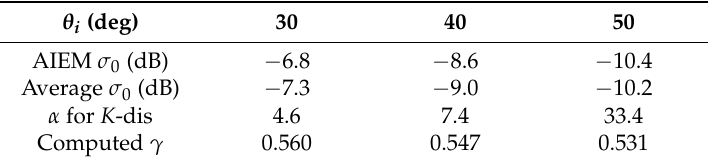
Figure 13. PDF curves of FDTD ‐ simulated backscattering amplitude at different θ i , at the footprint size of 30 mm, VV, compared with referencing Rayleigh distribution and K ‐ distribution, 1600 realizations. Sample and computation parameters are in Tables 1 and 3(set 1). Table 5. Comparisons of the average intensity values and amplitude speckle values from simulated backscattering results by 1600 realizations, at the footprint size of 30 mm, Sample and computation parameters are in Tables 1 and 3(set 1).